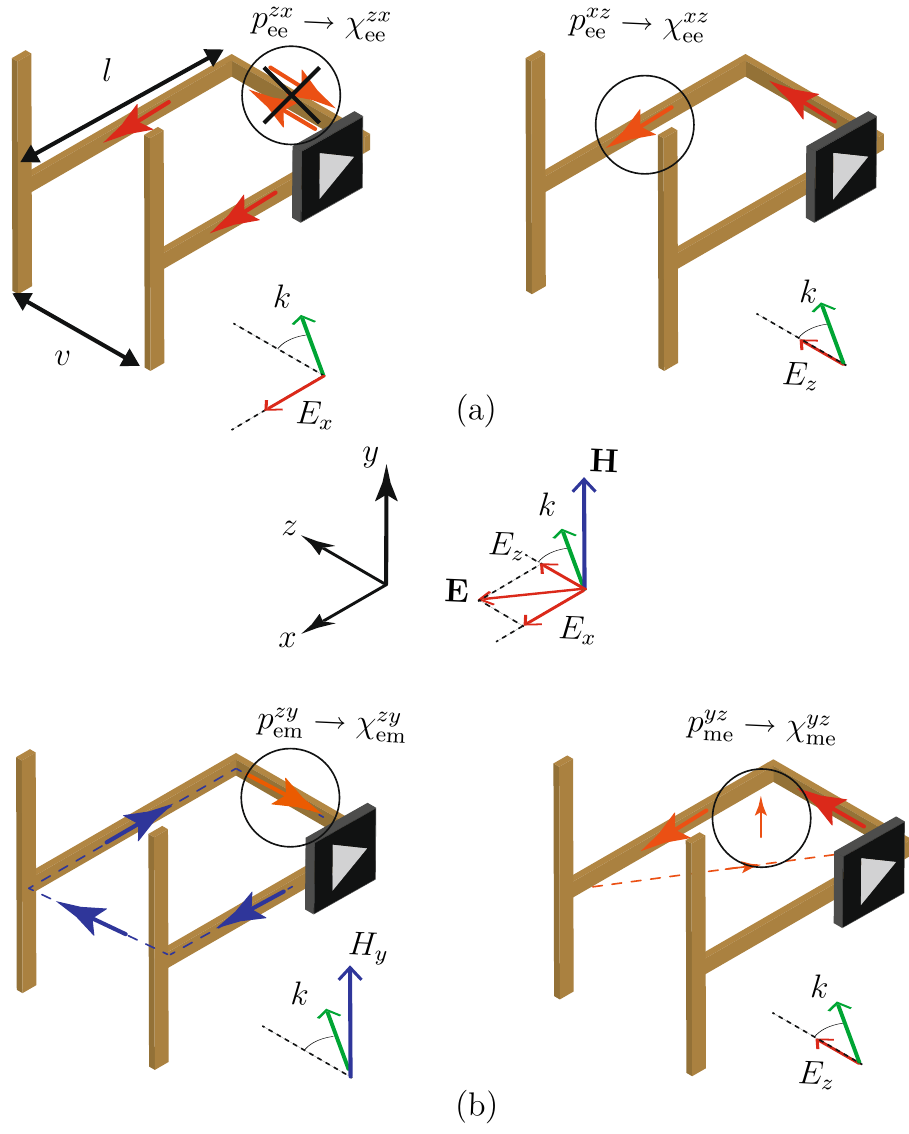
Figure 2. Operation principle of the transistor-loaded metaparticle, with orientation corresponding to Fig. 1. ( a ) Excitation E x (left) and E z (right), showing that χ zx ee = χ xz ee . ( b ) Excitation from H y (left) and E z (right), zy yz showing that χ em = − χ me . The drawing is not to scale: in reality, v ≪ l . The notation p component of the electric dipole response due to the y component of the magnetic field excitation, and so